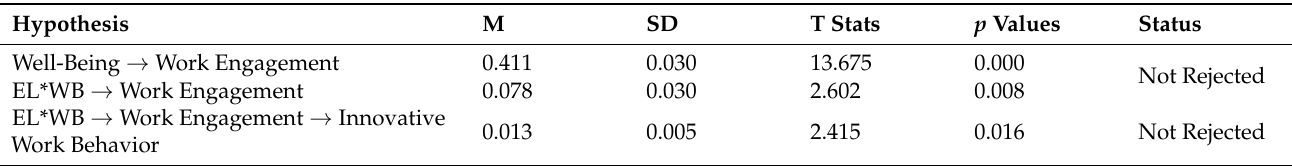
Table 9. Moderation and mediated